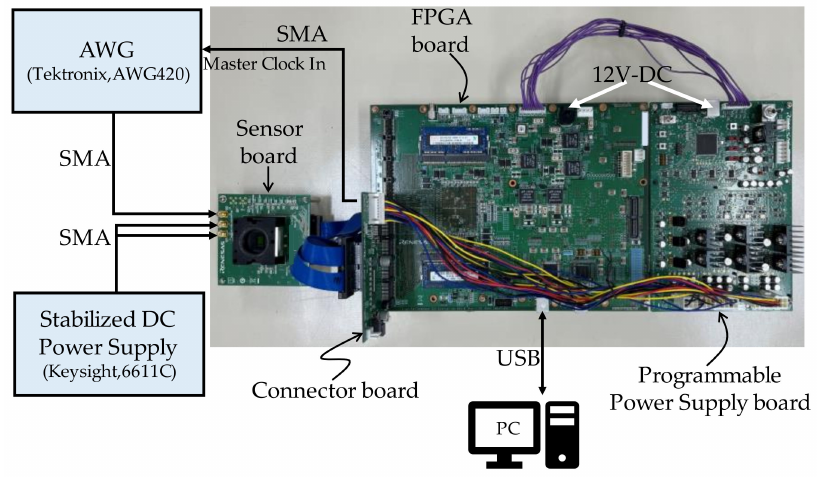
Figure 9. Evaluation